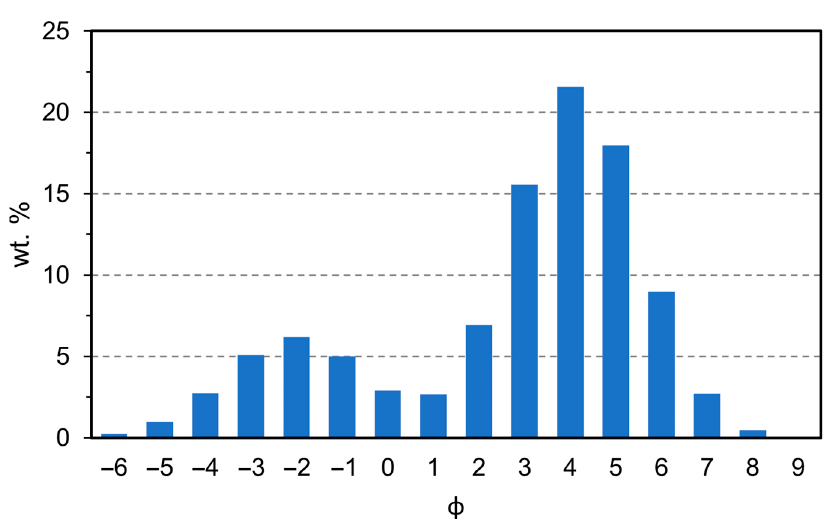
Figure 7. The total grain-size distribution of Sheveluch tephra during the 1964 eruption, determined using the FALL3D model.